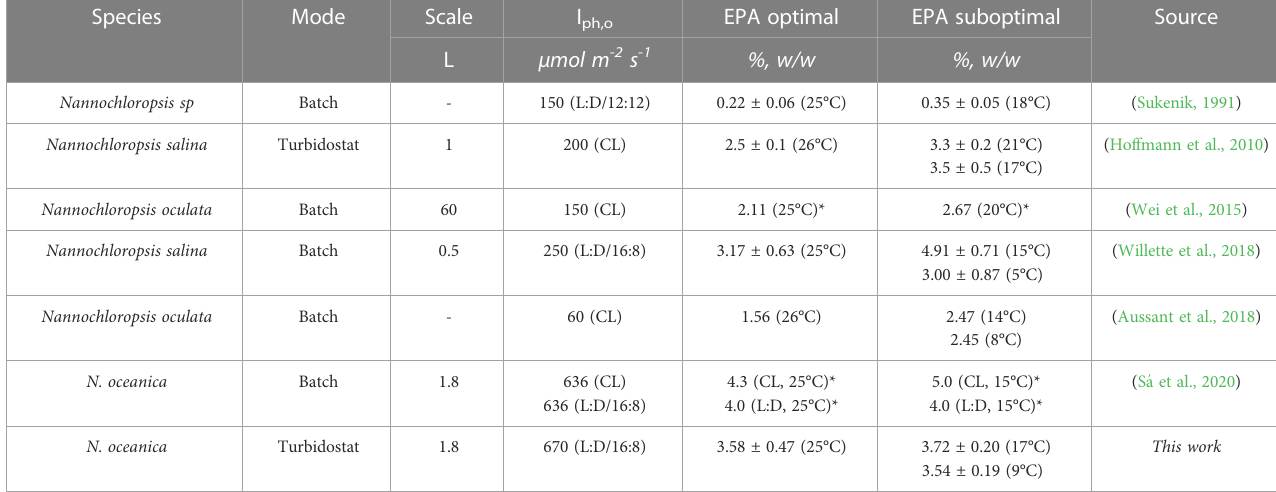
TABLE 2 EPA content at optimal and suboptimal conditions of different Nannochloropsis species at different experimental conditions (mode, scale and incident light intensity). Species